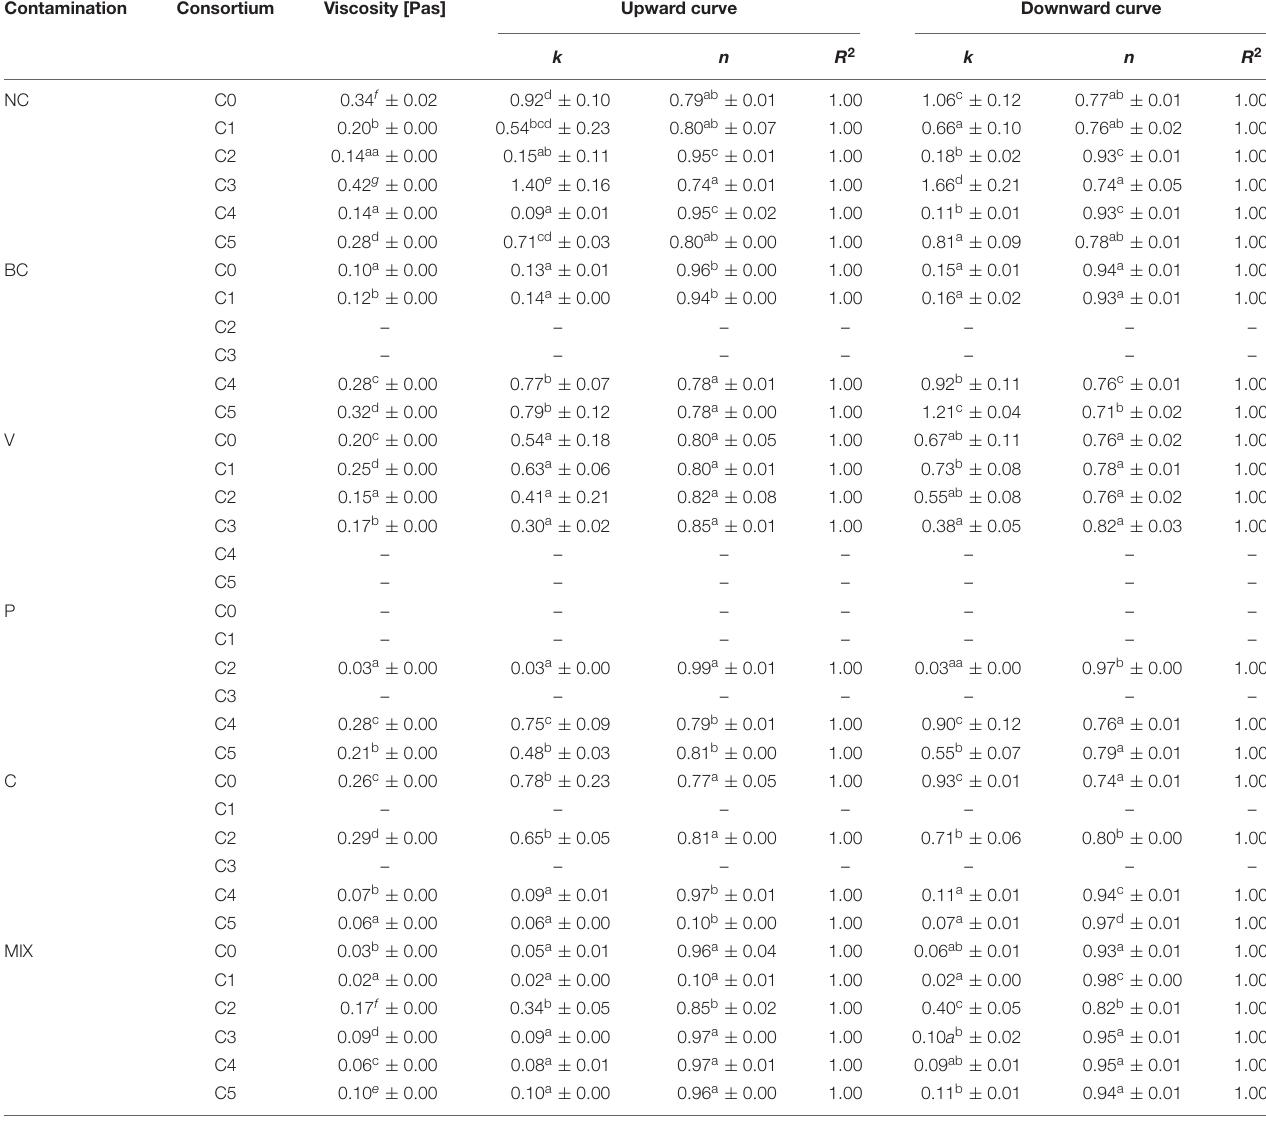
TABLE 1 | Parameters of the Ostwald–de Waele model describing the rheological properties of 1% strawberry pectin solutions. Contamination Consortium Viscosity [Pas] Upward curve Downward